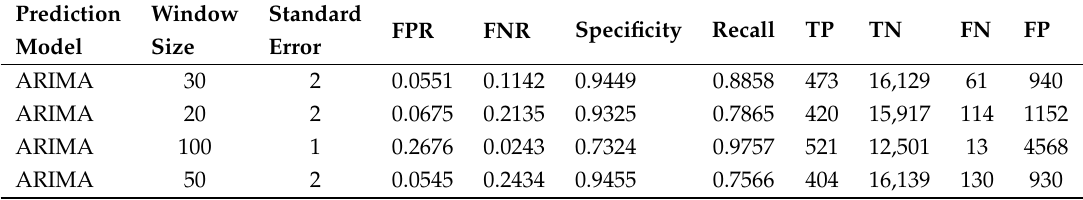
Table 4. False Positive Rate, False Negative Rate, Specificity, and Recall metrics for Exp